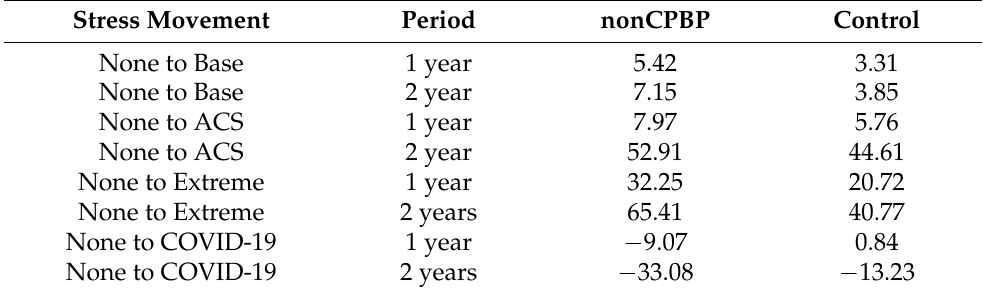
Table 2. Summary % changes in predicted capital: nonCPBP, control, extreme, and COVID-19 data subject to base and ACS economic conditions. Increasing capital is indicated as economic stress increases after severity in both years 1 and 2.